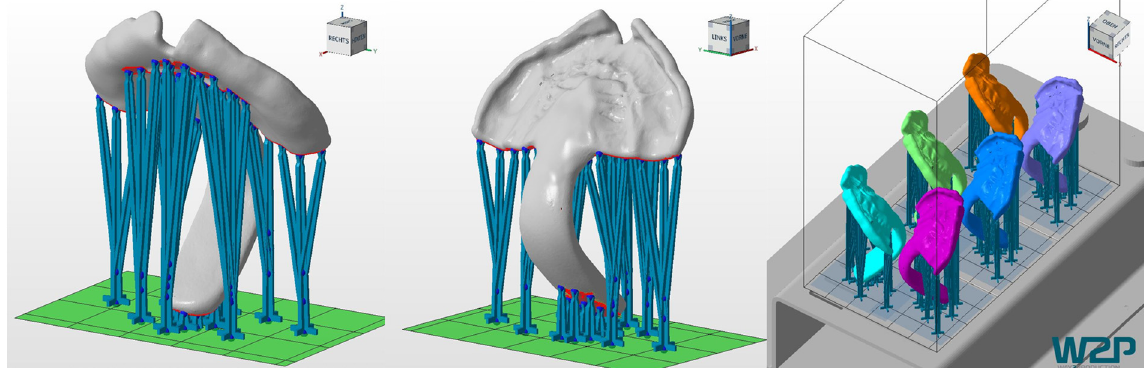
Figure 5. Printing job of the TPPs in Netfabb Premium 2019. Left and middle: TPP with support structures. Right: placement of the six TPPs in the building platform of the Solflex 350.